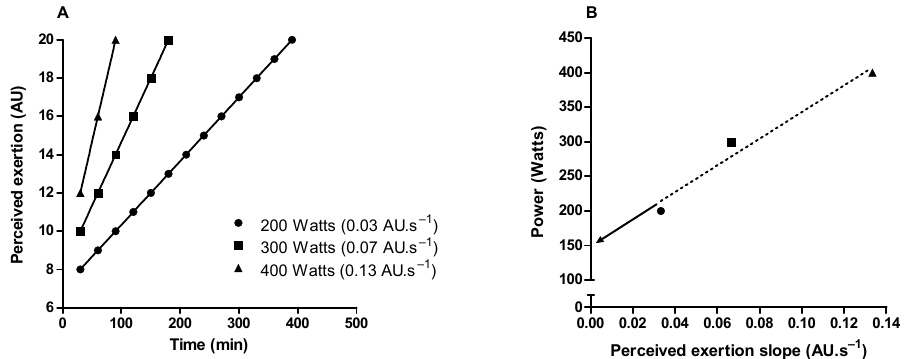
Figure 5. Illustration of critical power determination by obtaining the perception of exertion through- out constant load tests in the severe-intensity domain. ( A ) Shows perceived exertion over time in three constant-load exercise tests. ( B ) Shows the linear relationship between the power used in the constant-load exercises tests and the rate of perceived exertion increase over time (perceived exertion slope). Critical power is the intercept (arrow) of the linear